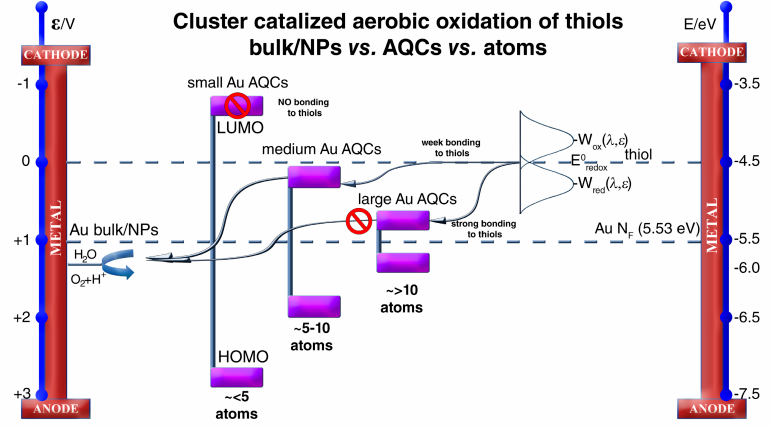
Figure 10. Schematic representation of possible aerobic oxidation routes of thiols by bulk, NPs and gold clusters. The electronic band structure of Au clusters of different sizes on an absolute scale is represented (right) and the potential scale relative to a standard hydrogen electrode (SHE). W ox (λ,ε) and W red (λ,ε) stand for the oxidized and reduced states of thiols in solution, which can be represented by Gaussian distributions with a standard deviation of 2 λk B T, with their maxima located at E 0 redox ± λ, λ being the reorganization energy ( ≥ 0.3 eV) and E 0 redox the standard energy of the thiol redox